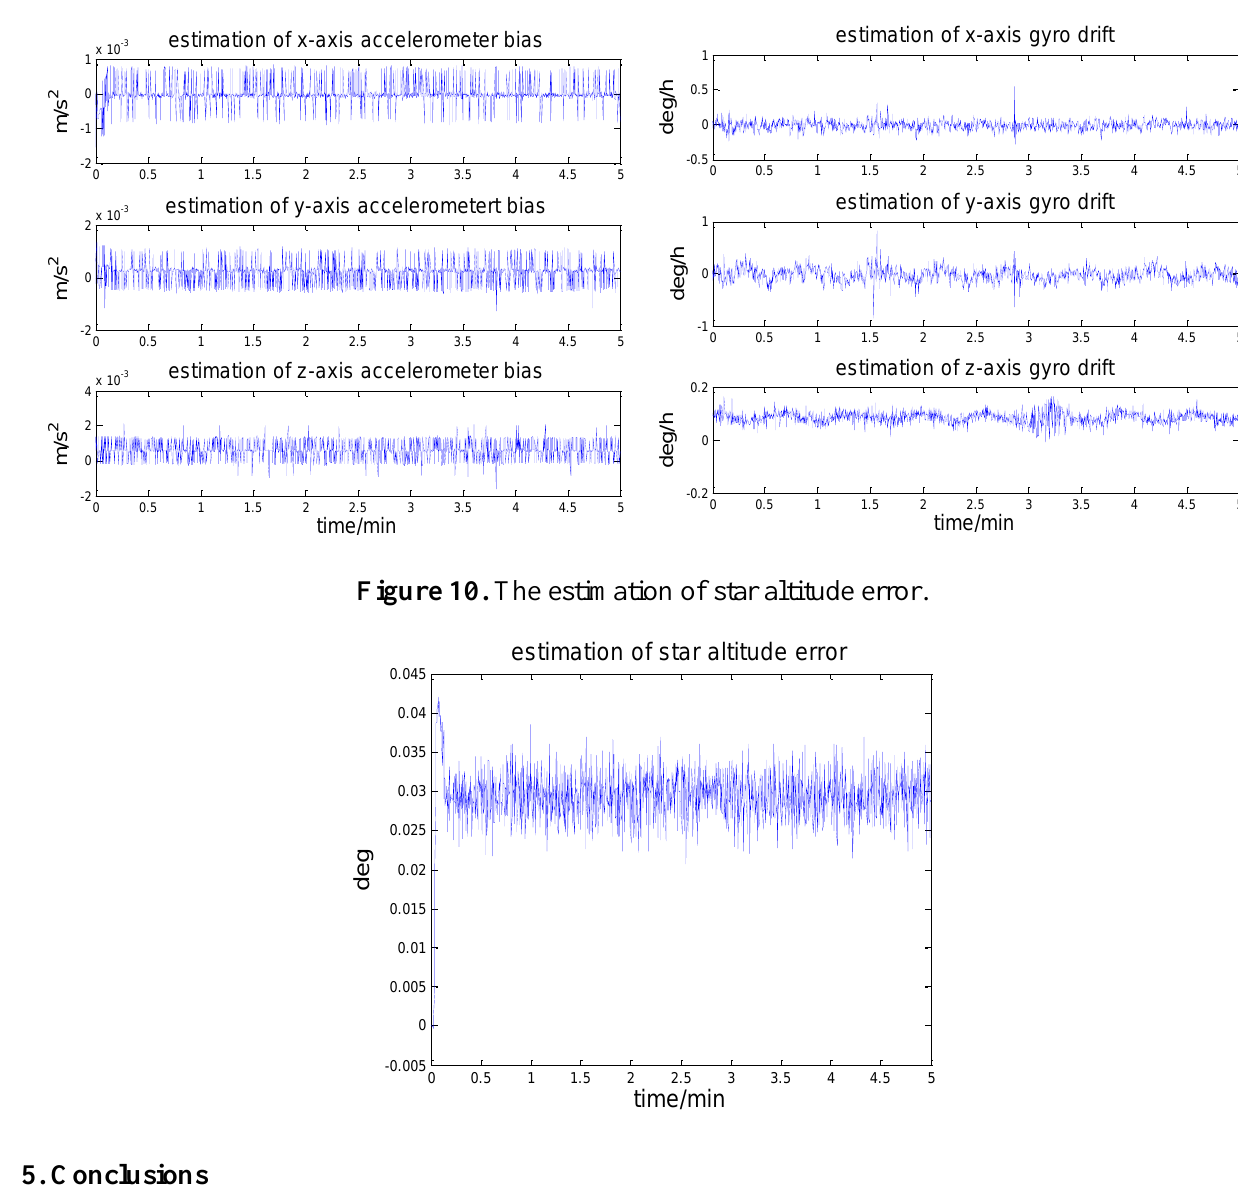
Figure 9. The estimation of accelerometer and gyroscope errors.